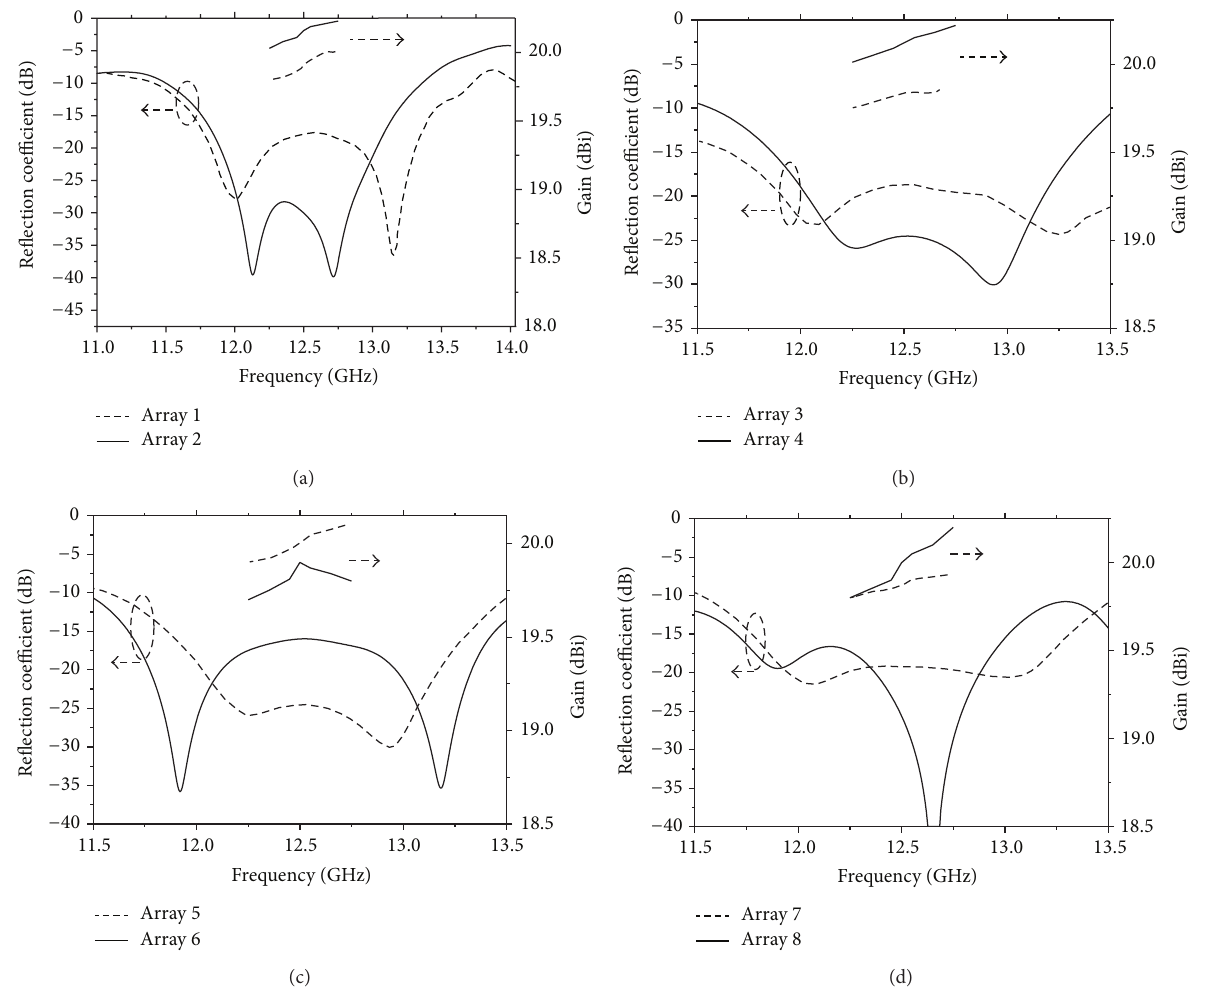
Figure 5: The simulated reflection coefficient and gain of the notched array (a) V-polarization, (b) H-polarization and concave array, (c) V-polarization, and (d)